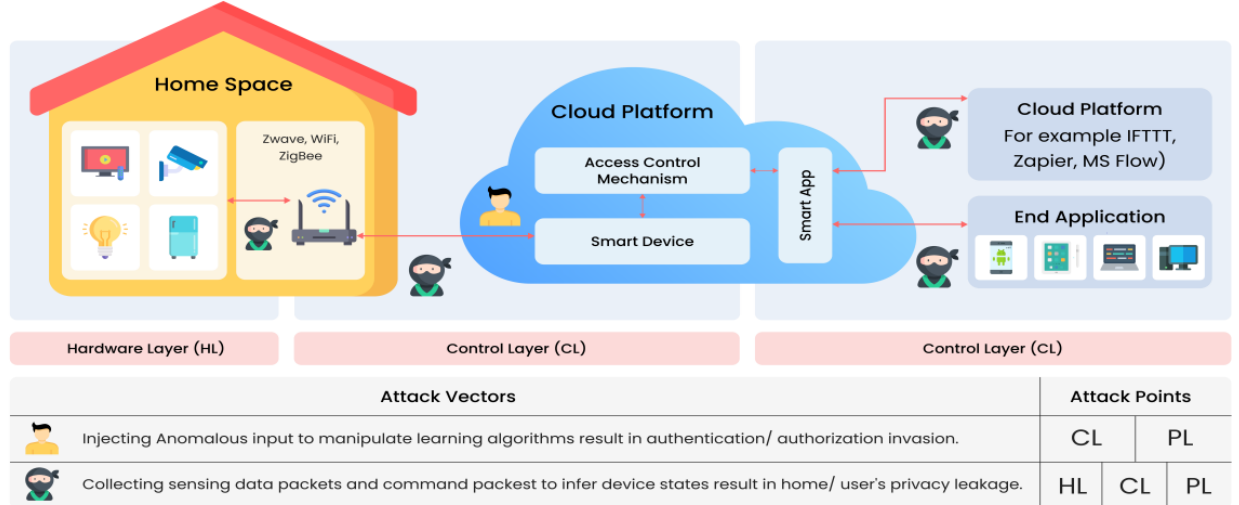
Figure 1. IDS in a Smart Home Network.